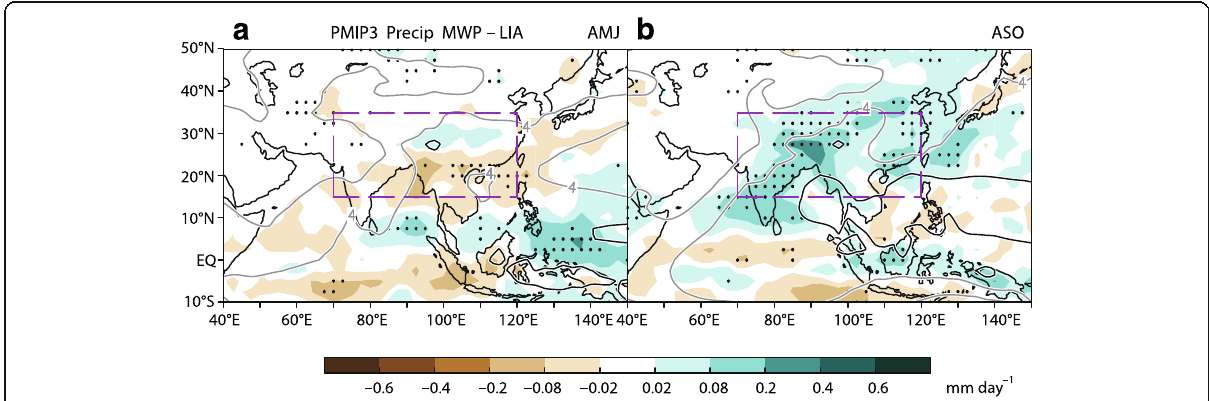
Fig. 2 ML anomaly in seasonal mean, 10-model ensemble mean precipitation (mm day − 1 ). a AMJ and ( b ) ASO. Stipples indicate the areas with 95% statistical confidence. Gray (1 and 4 mm day − 1 ) and black (8 mm day − 1 ) contours represent the climatology of precipitation during the LIA. The dashed purple rectangle indicates the area examined in Table